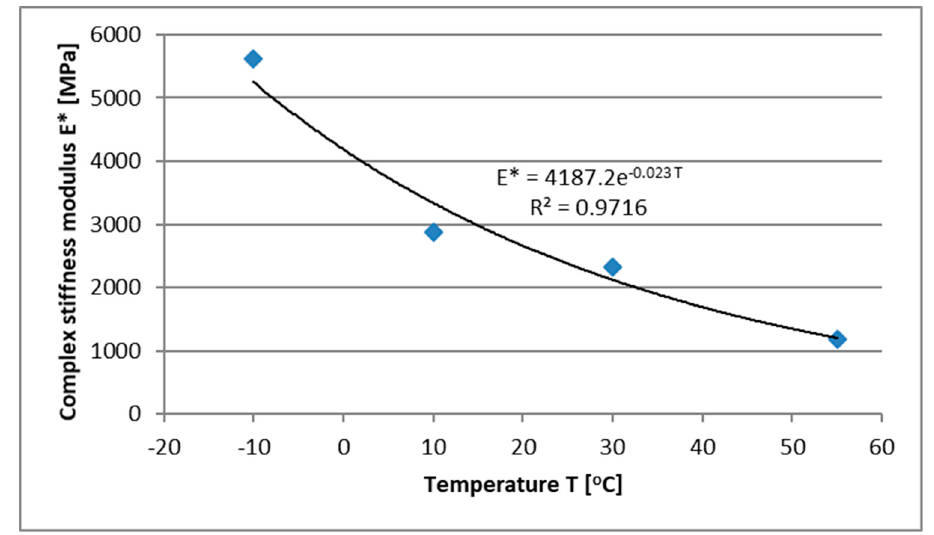
Figure 4. Changes in the FAC mixture stiffness as a function of temperature.